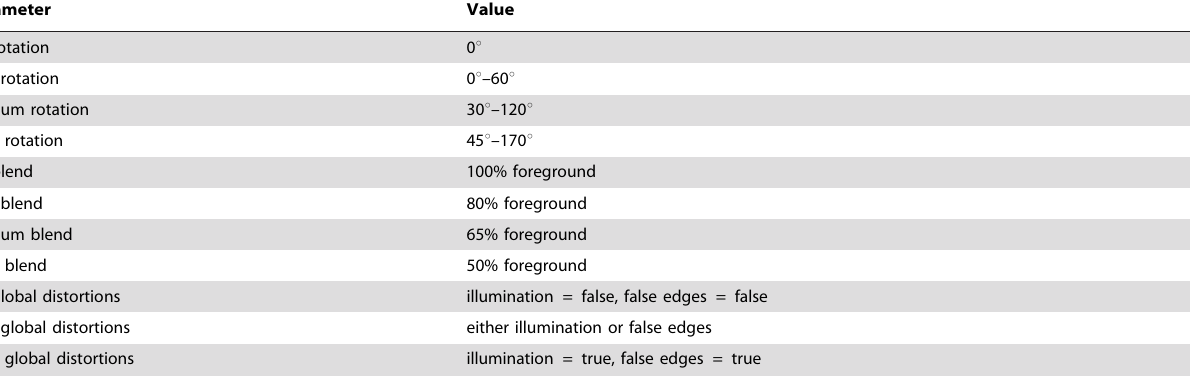
Table 2. Human performance for each set of CAPTCHAs during parameter optimization phase.